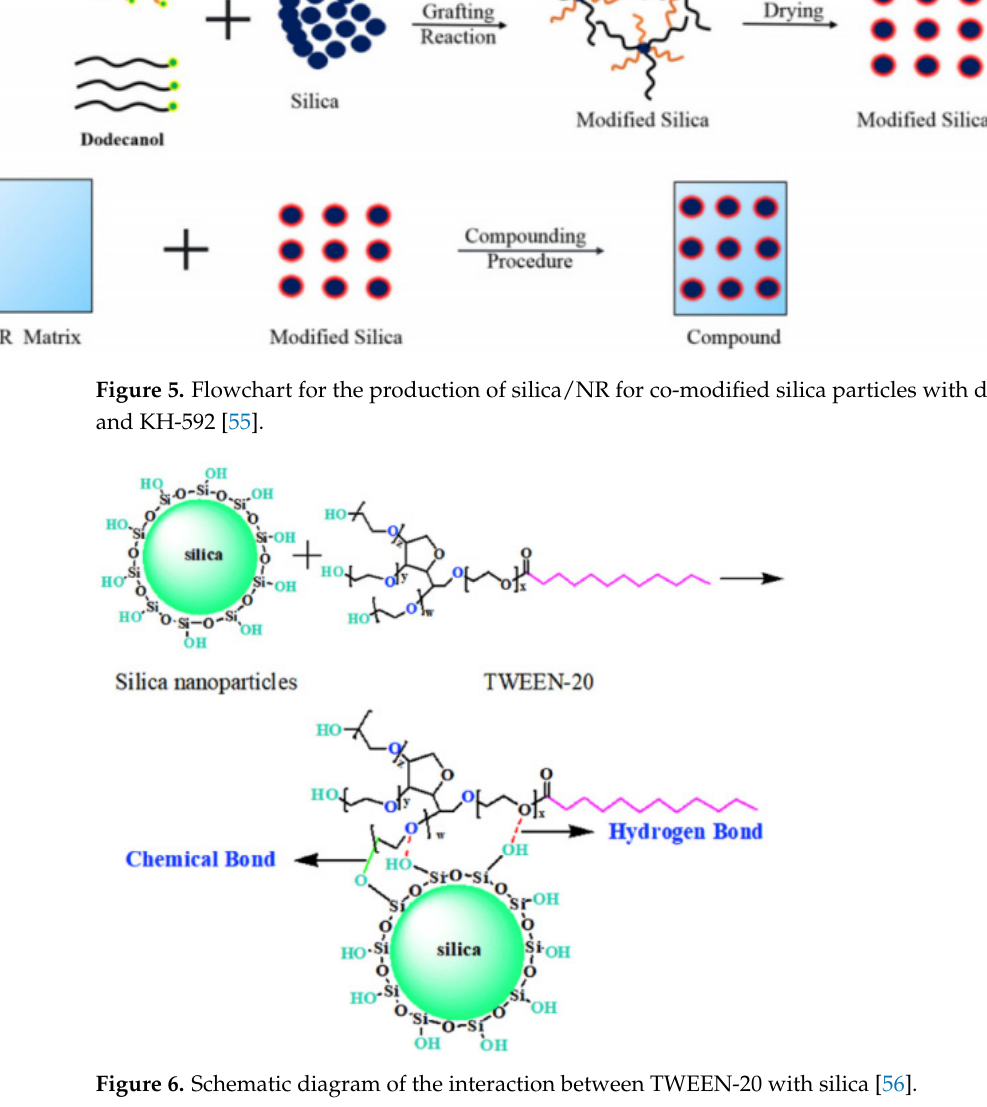
Figure 5. Flowchart for the production of silica/NR for co-modified silica particles with dodecanol and KH-592 [55].